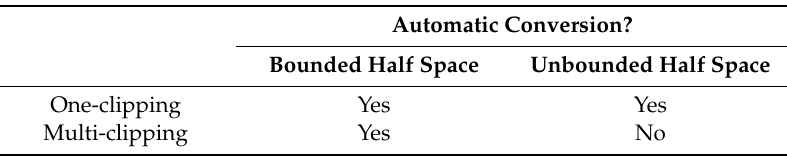
Table 1. Types of clippings and types of half spaces.